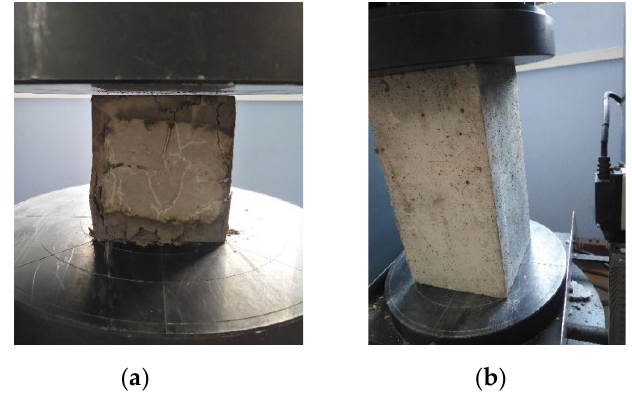
Figure 4. Compressive strength test: ( a ) cubes; ( b ) prisms.